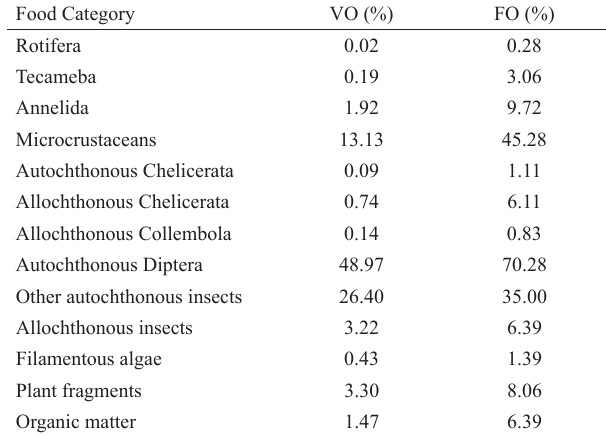
Table 1. Volume (VO%) and frequency of the occurrence